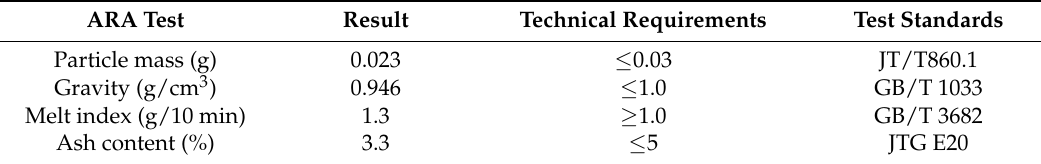
Table 4. Properties of anti-rutting agent (ARA) used in this